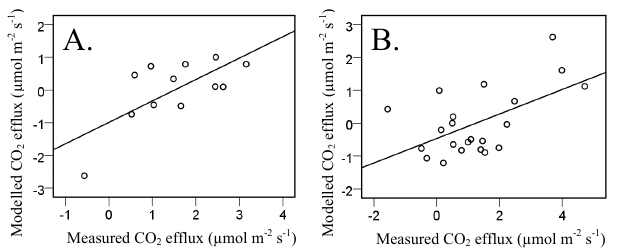
Figure 4. (a) Modelled values of mangrove forest CO 2 ef- flux compared to measured CO 2 efflux (modelled CO 2 efflux (µmolm − 2 s − 1 ) = 2 . 454 − 0 . 215 × mangrove biomass, r 2 = 0.49, p <0.05). (b) Modelled values of cleared mangrove forest CO 2 efflux compared to measured CO 2 efflux (modelled CO 2 efflux (µmolm − 2 s − 1 ) = 0.0713 + 0.430 × sediment organic carbon con- centration, r 2 = 0.32, p